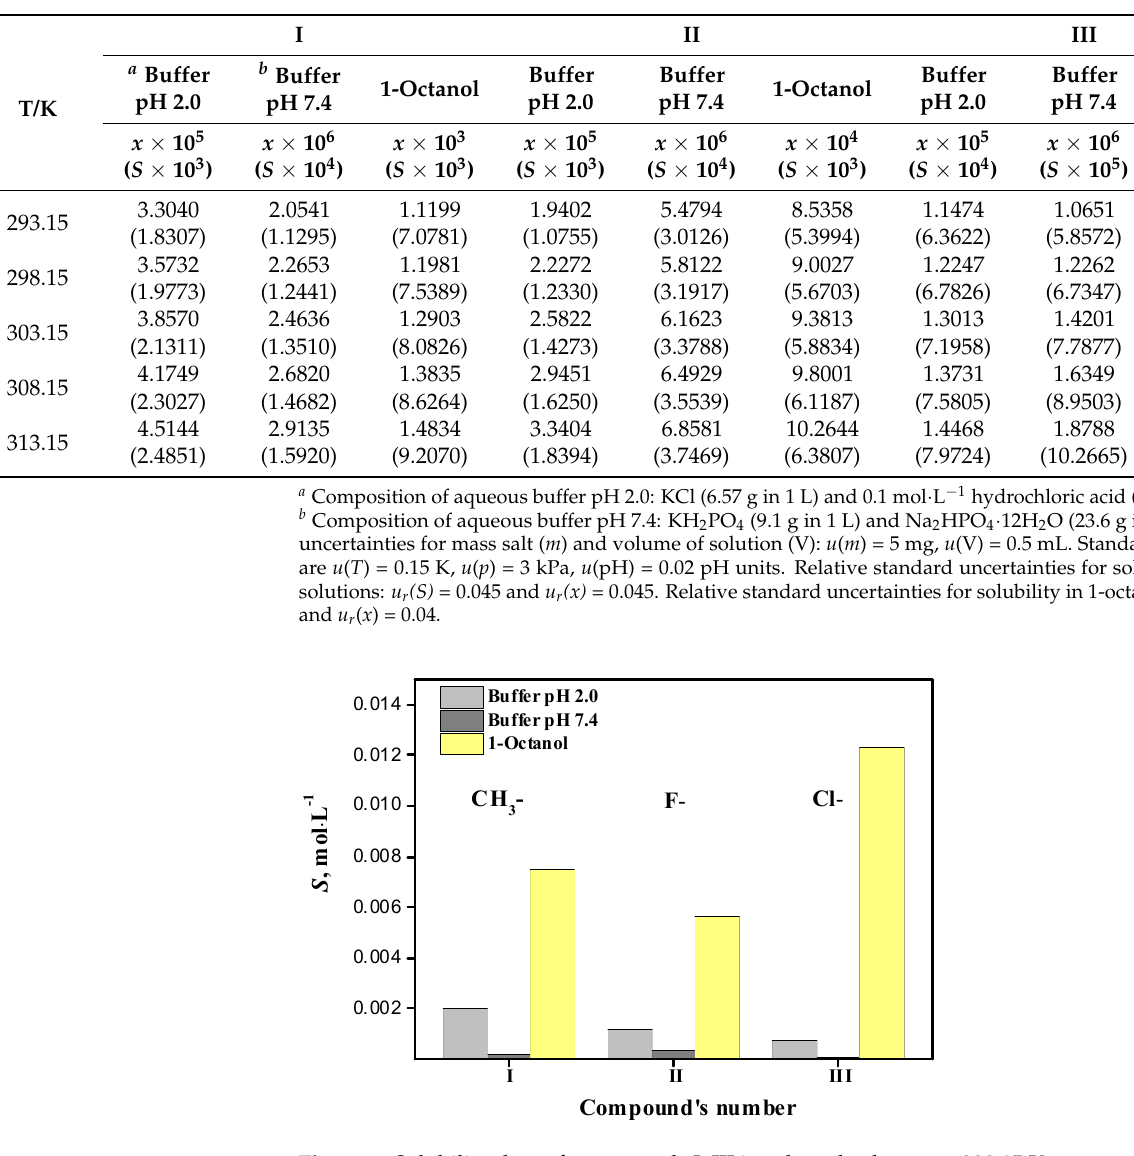
Table 2. Solubility ( S , mol·L − 1 and x , mol. frac.) of compounds studied (amorphous state) in buffer solutions (pH 2.0 a and 7.4 b ) and 1-octanol at different temperatures and pressure p = 0.1 MPa. T/K